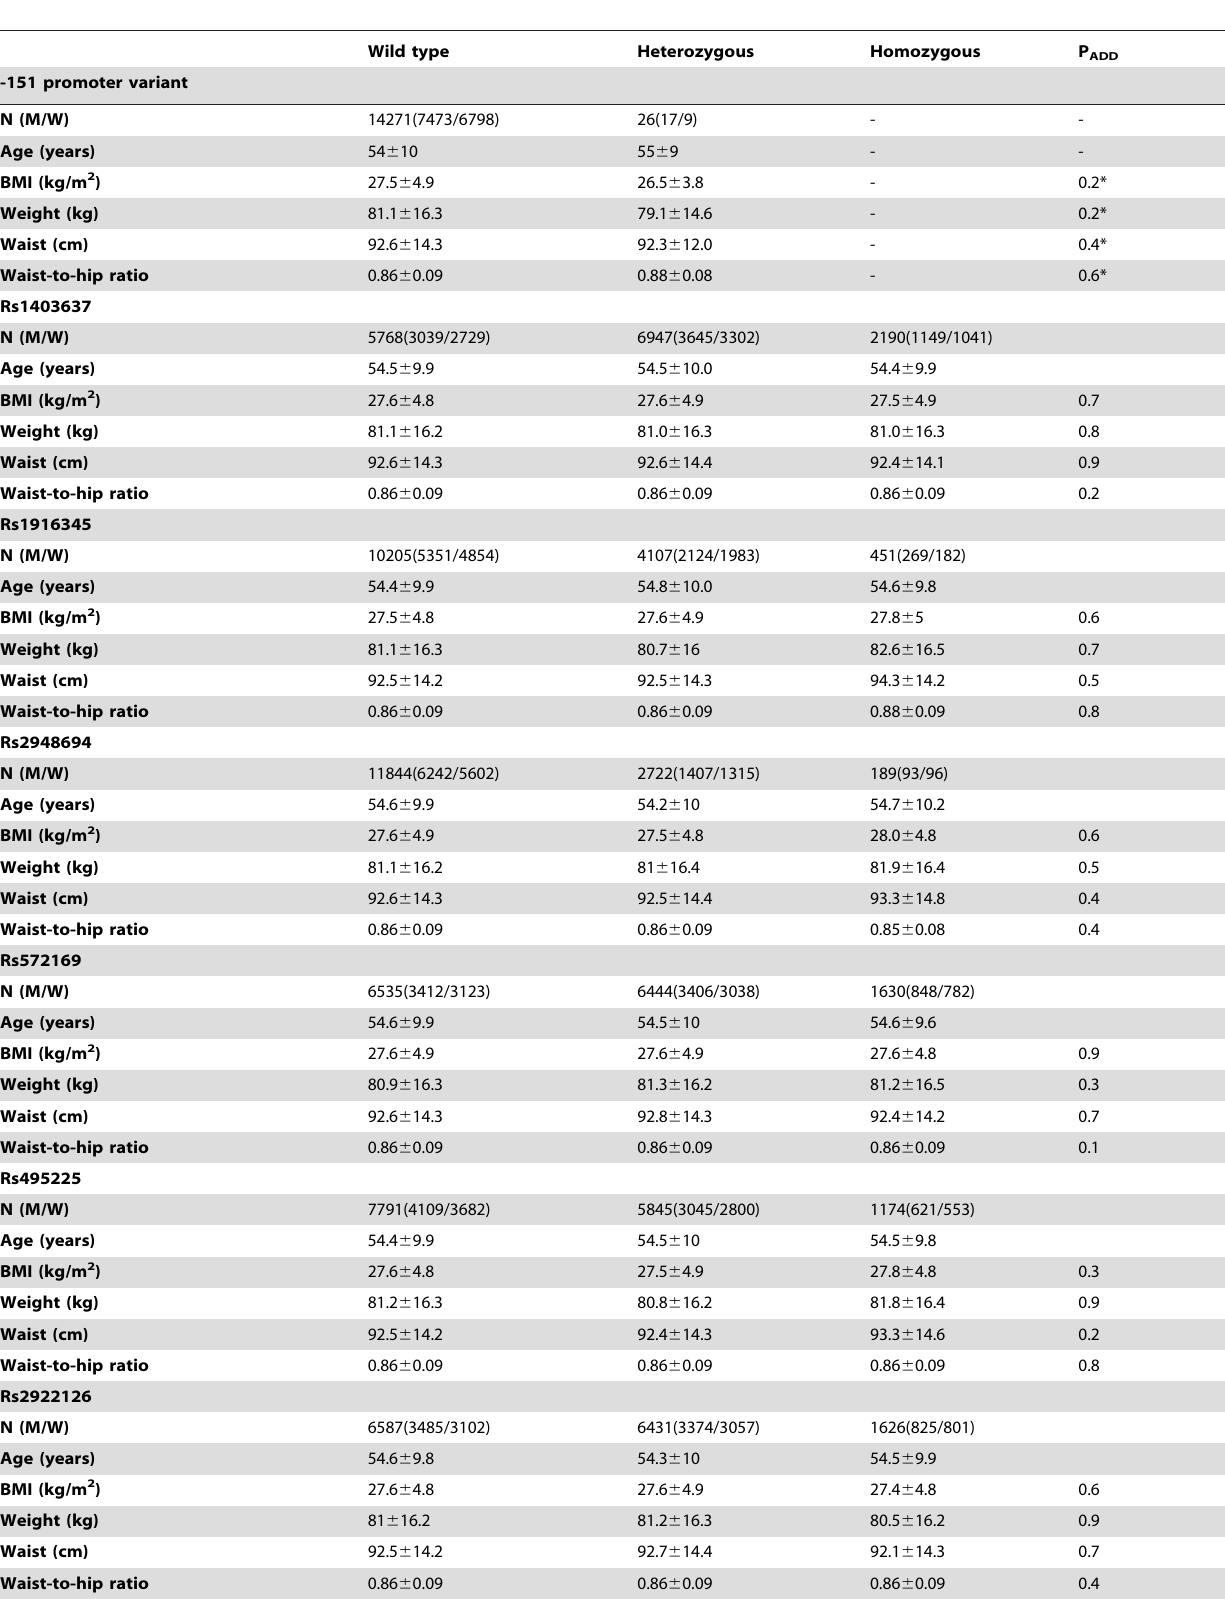
Table 1. Studies of associations between GHSR -151 promoter variant and quantitative traits in 15,854 Danes without known type 2